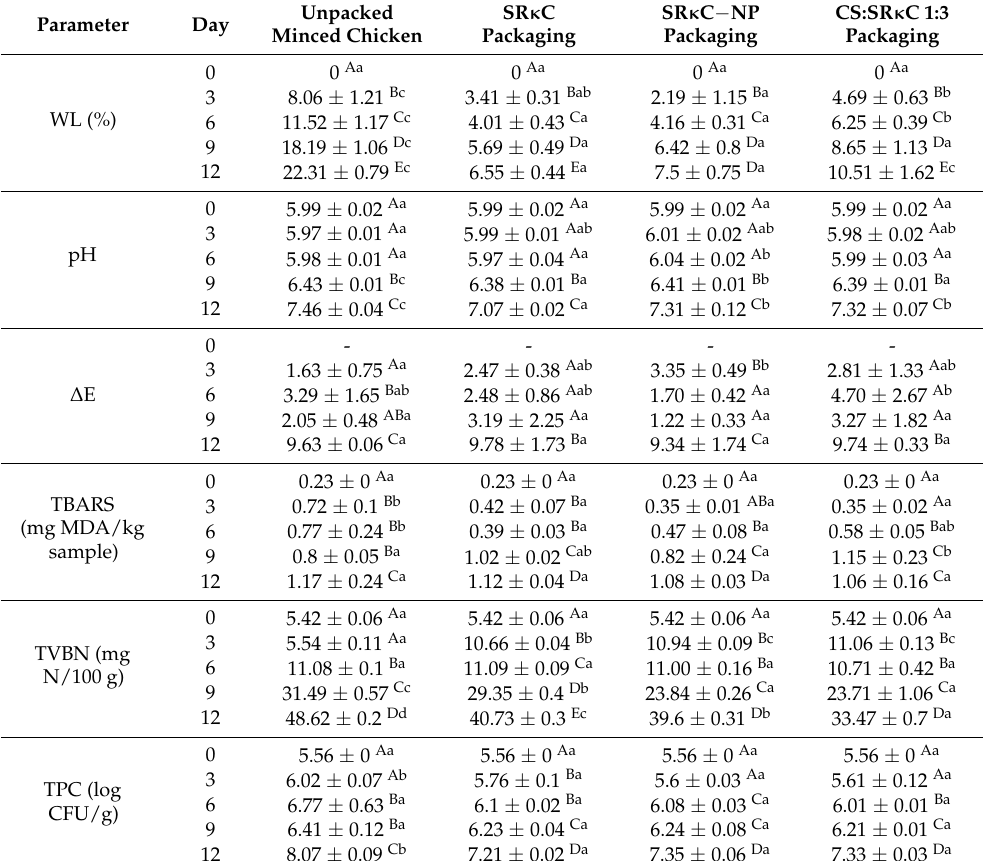
Table 5. Physicochemical and microbiological quality of minced chicken meat packaged with various treatments. Parameter Day